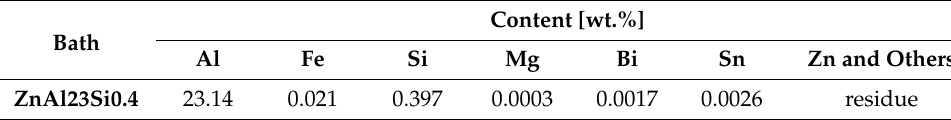
Table 7. Chemical composition of reference ZnAl23Si0.4 bath. Bath